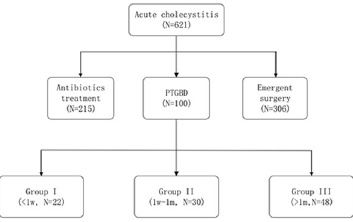
Figure 1. Study flow chart. PTGBD: percutaneous transhepatic gallbladder